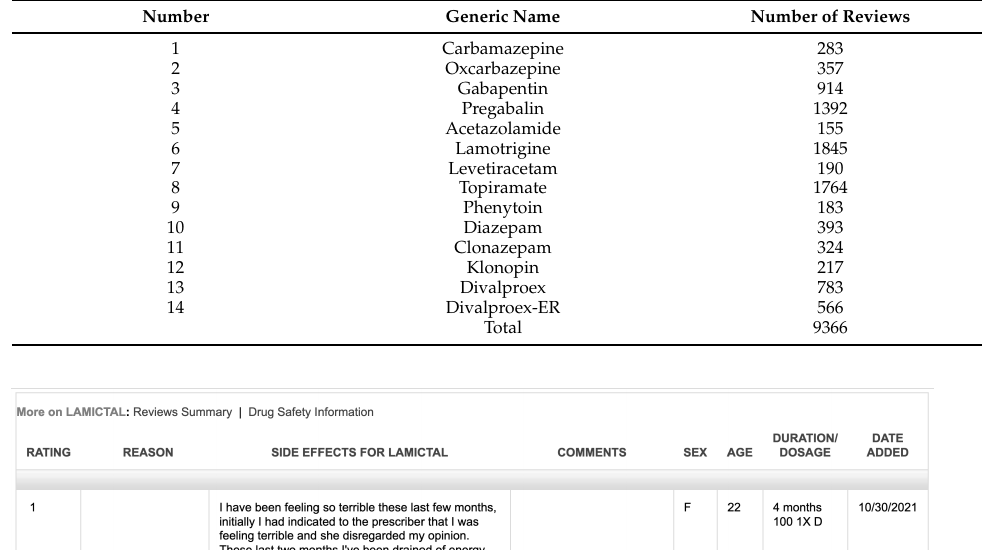
Table 1. List of AEDs.